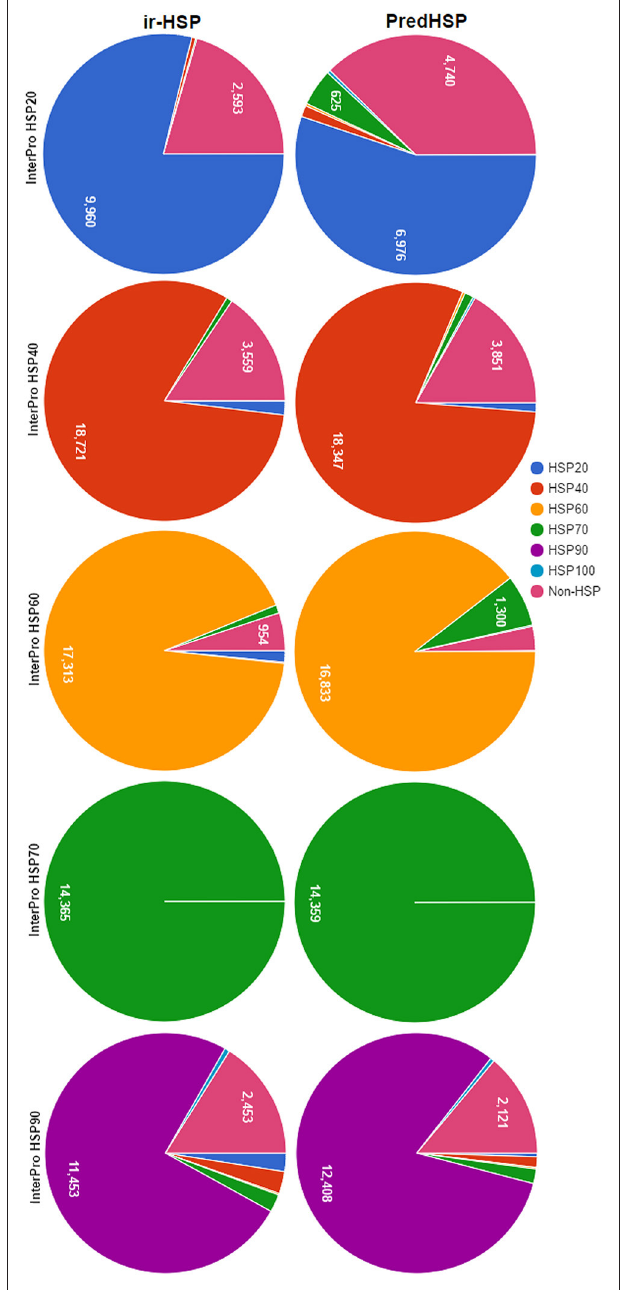
FIGURE 4 | Pie charts showing the number of correctly predicted HSP by ir-HSP (proposed approach) and PredHSP, for different families of HSPs collected from InterPro database. In case of HSP20, HSP40, HSP60, number of correctly predicted HSPs by ir-HSP are higher than that of PredHSP, whereas in HSP90 PredHSP performed better than ir-HSP. Almost all the HSPs are correctly predicted by both the approaches for